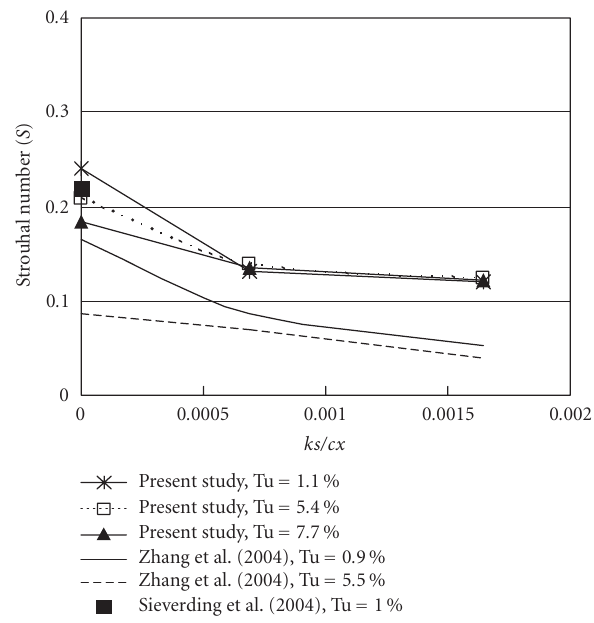
Figure 11: Vortex shedding frequency Strouhal numbers as depen- dent upon the normalized equivalent sand grain roughness size for di ff erent inlet turbulence intensity levels. Results are based upon power spectra density profiles measured in the pressure side wake at y/cx = 0 . 10 one axial chord length downstream of the cambered